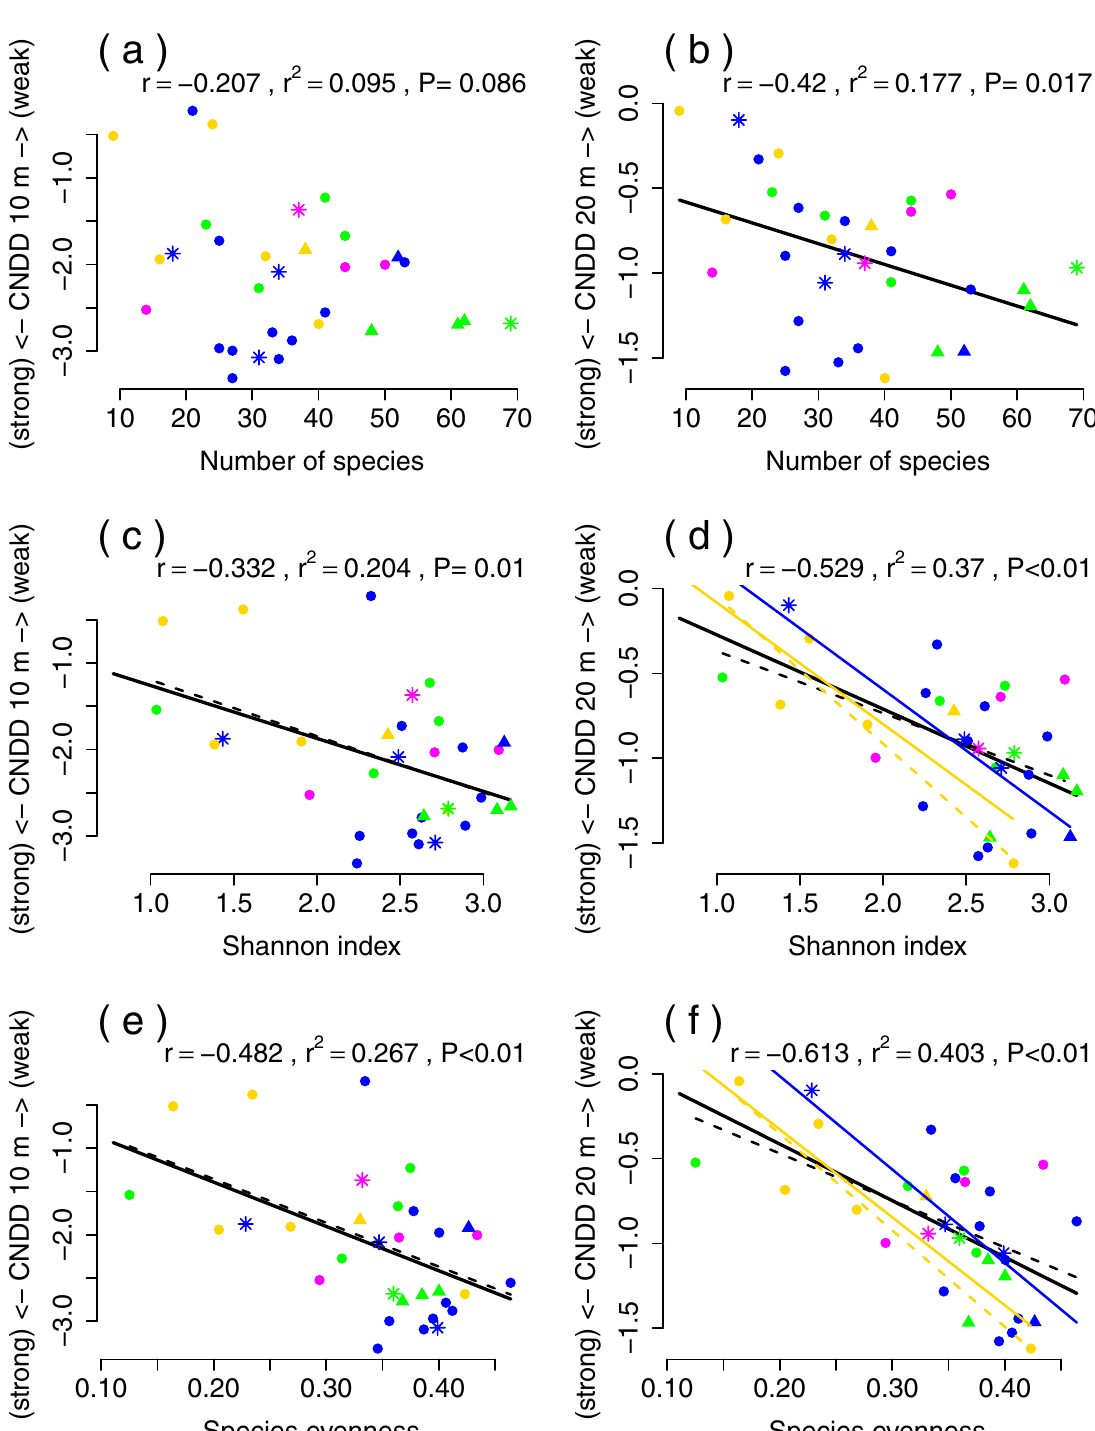
Figure 3. Correlations of CNDD with the species number, Shannon index and species evenness for 10 m ( a , c , e , g ) and 20 m ( b , d , f , h ) scales. Coloured points correspond to four forest functional types and point characters classify forests according succession stage. Coloured lines are shown if there was a significant linear correlation (P ≤ 0.05) inside the forest type, except black line that corresponds to an overall correlation without considering the forest types and succession stages. Solid lines are used for correlations of all forest succession stages and dashed lines represent correlation limited to old growth forests. Forest types are shown by colours: evergreen broad-leaved, deciduous broad-leaved, broad-leaved and conifer, and evergreen conifer. r is Spearman correlation coefficient, P is significance and r 2 is a fraction of variance explained by the linear model of overall correlation (all types and succession stages of